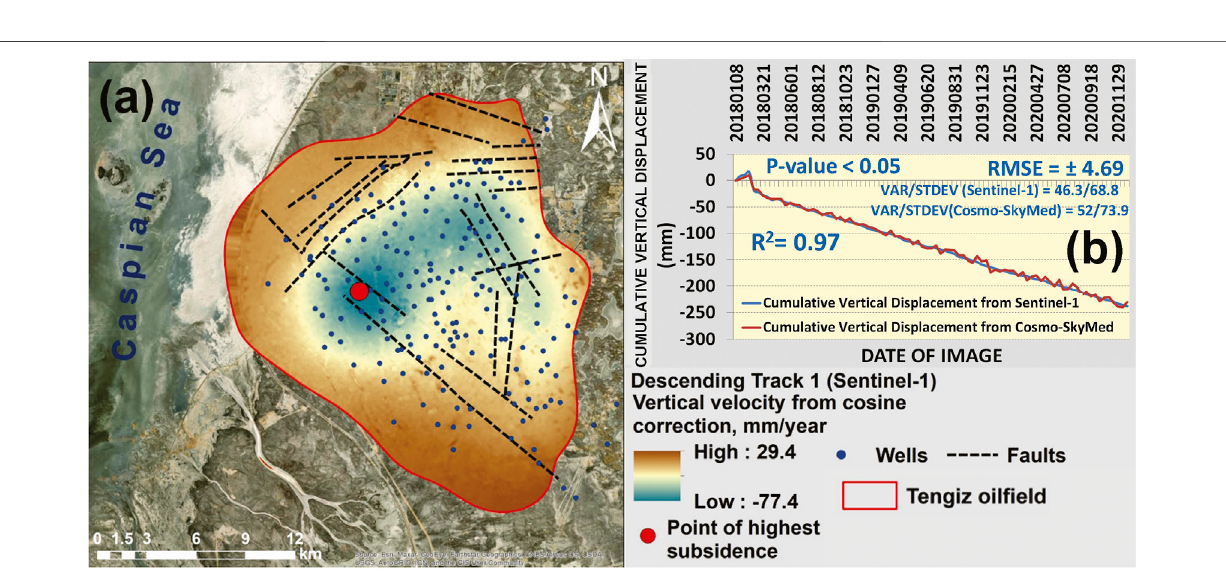
FIGURE10|(A) LocationofthemostsubsidinglocationbasedonthecumulativeverticaldisplacementderivedfromtheSentinel-1images; (B) regressionanalysis between the cumulative vertical displacements derived from the Sentinel-1 and COSMO-SkyMed satellite images for the most subsiding location.